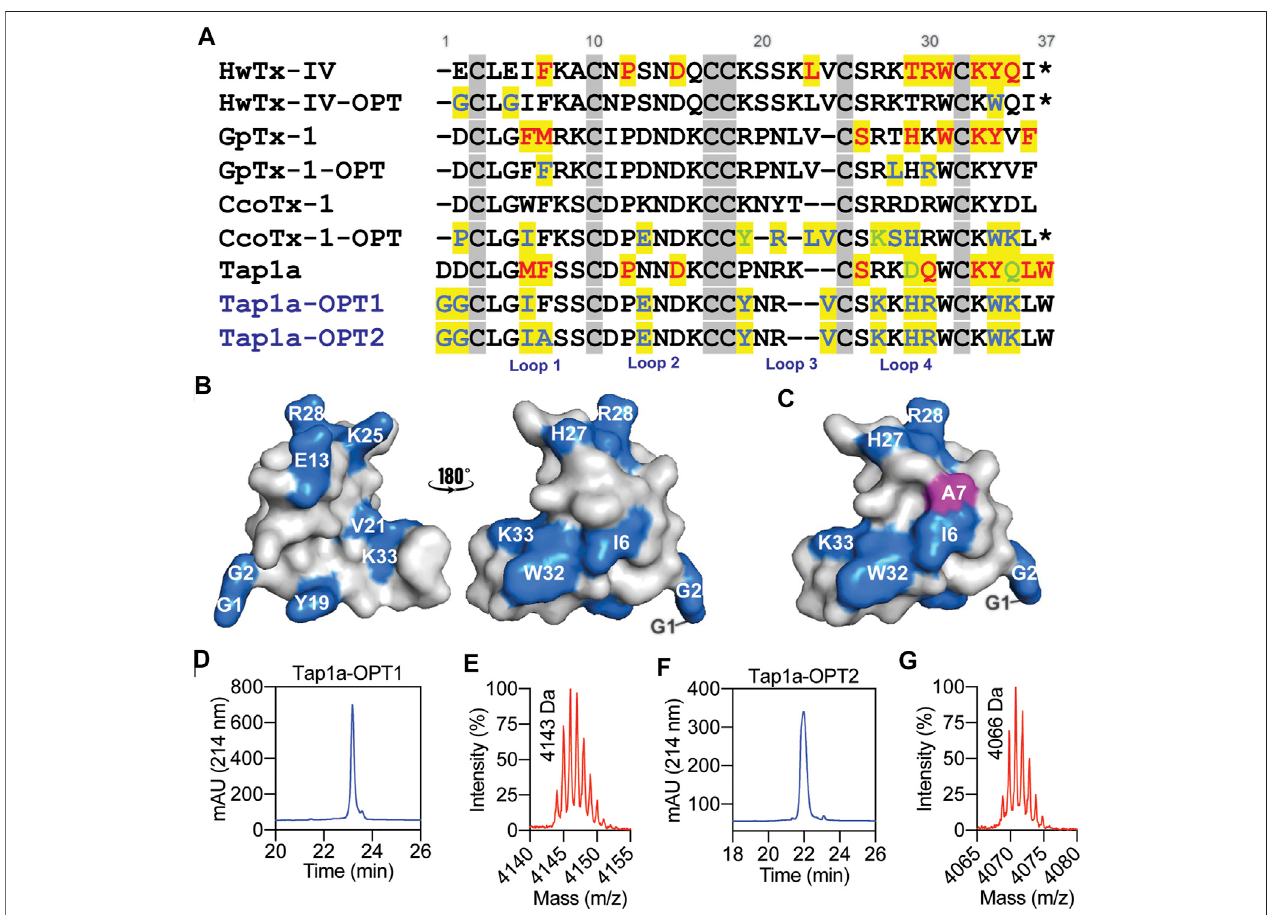
FIGURE 2 | Rational design of Tap1a-OPT1 and Tap1a-OPT2, and peptide production via recombinant expression. (A) Alignment of NaSpTx1 spider peptides which were pharmacologically optimized for Na V channels inhibition (Cardoso and Lewis, 2019), and Tap1a, Tap1a-OPT1 and Tap1a-OPT2. Residues coloured in red are positions where substitutions led to Na V -activity loss reported in previous studies and for Tap1a in this work, and residues coloured in blue and green are substitutions that enhanced potency and selectivity for Na V s, respectively. Residue substitutions in Tap1a-OPT1 and Tap1a-OPT2 are highlighted in blue. Cysteinesareingreyboxes. (B,C) Modelofthethree-dimensionalstructuresofTap1a-OPT1 (B) andTap1a-OPT2 (C) highlightinginbluethesubstitutionsintroducedin Tap1a-OPT1 and in pink the additional substitution F7A introduced in Tap1a-OPT2. (D – G) Production of the peptides Tap1a-OPT1 and Tap1a-OPT2. RP-HPLC chromatogram and mass spectrometry analysis results of the puri fi ed recombinants Tap1a-OPT1 (D, E) and Tap1a-OPT2 (F, G) puri fi ed in C18 column using a TFA/ ACN gradient. Mass spectrometry analysis of puri fi ed peptides displayed the expected masses of 4143 Da for Tap1a-OPT1 (E) and 4066 Da for Tap1a-OPT2 (G) .